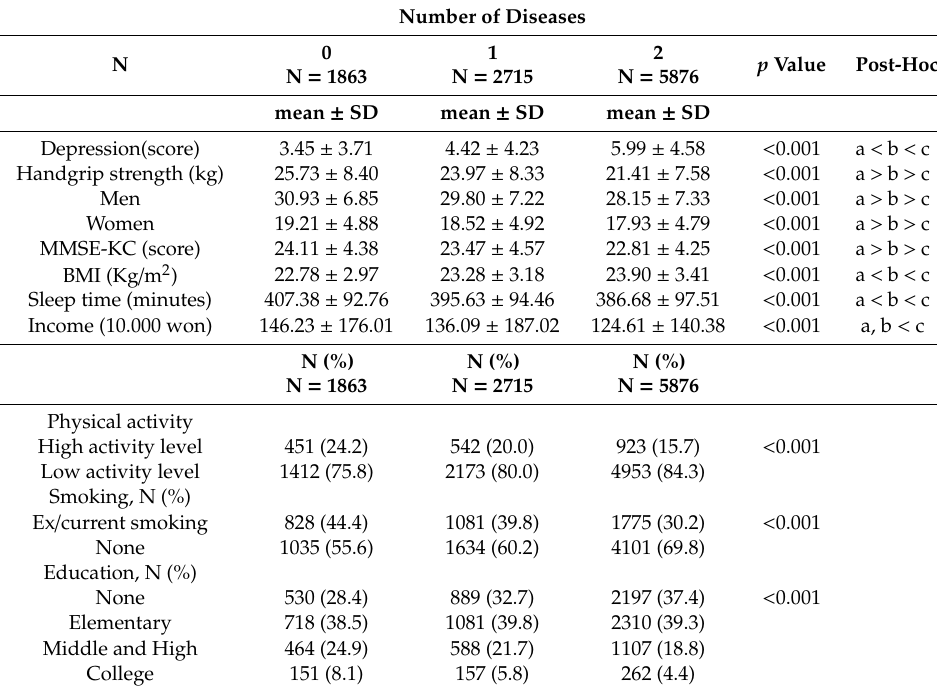
Table 2. Comparisons of variables following the number of chronic diseases.